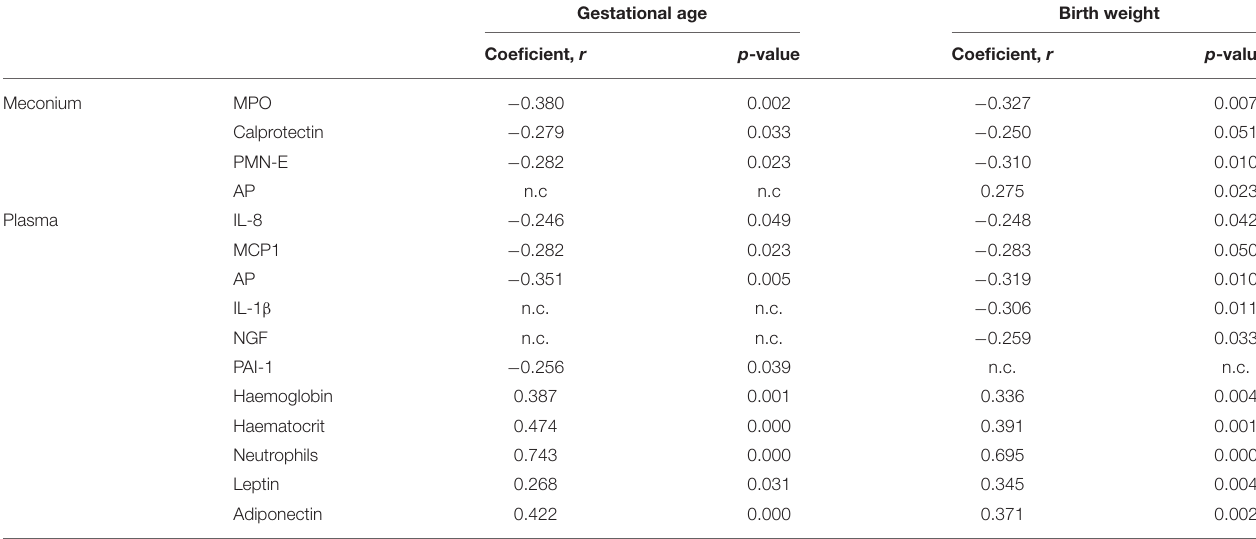
Gestational age Birth weight Coeficient, r